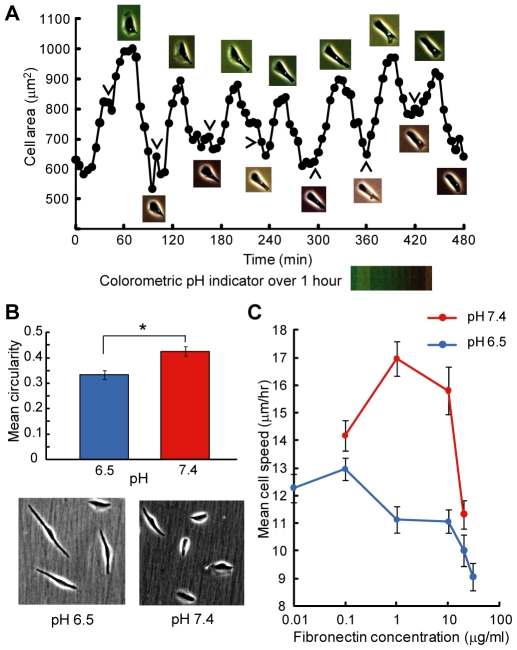
Cell spreading, morphology, and migration speed are altered at acidic extracellular pH.(A) Cell area for a representative cell over 8 hours, during which media pH was changed to pH 6.0 every hour. After each pH change, media pH drifted up to ∼7.2 due to presence of bicarbonate buffer, as evidenced by the color change of the pH indicator in the media (shown for 1 hour). Images are snapshots of the cell at area minima and maxima. Arrowheads indicate point immediately before media pH was brought down to pH 6.0. Each hour, cell area increased immediately after pH was dropped to 6.0, and decreased as pH drifted up. (B) Mean cell circularity 8 hours after changing media pH for adhered αvβ3 CHO-B2 cells. Cell circularity was significantly lower at pH 6.5 than at pH 7.4 (asterisk indicates p = 0.0002). Images are representative for cells at pH 6.5 and pH 7.4. (C) Mean cell migration speed as a function of fibronectin coating concentration. Maximum migration speed occurred at a lower fibronectin concentration when cells were in acidic pH. Statistical significance of maximum migration speed value at pH 7.4: 0.1 vs. 1 µg/ml, p<0.05; 1 vs. 20 µg/ml, p<0.001; 1 vs. 30 µg/ml, p<0.001. For pH 6.5: 0.1 vs. 1 µg/ml, p<0.1; 0.1 vs. 10 µg/ml, p<0.05; 0.1 vs. 20 µg/ml, p<0.001; 0.1 vs. 30 µg/ml, p<0.001. All error bars represent SEM.